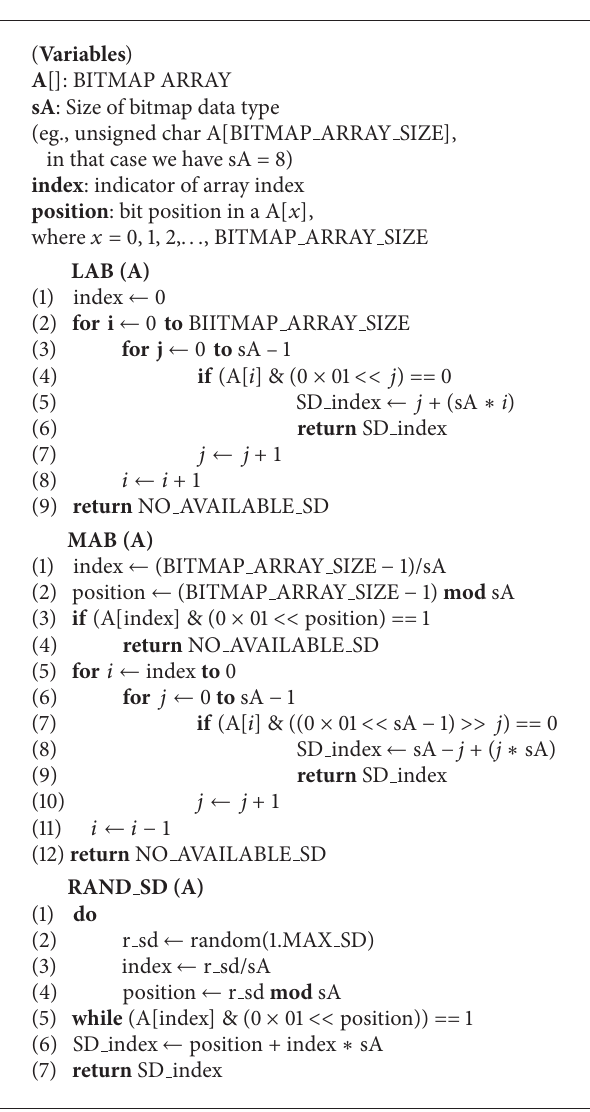
Algorithm 1: Possible SD slot selection